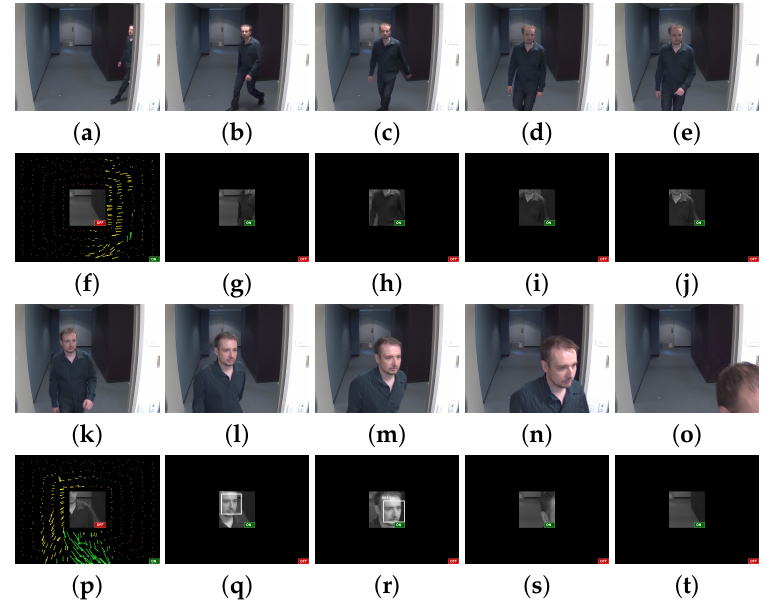
Figure 6. Example of a simulation using one of our ARIMs and a sample sequence from the employed dataset [19]. Images ( a – e ) and ( k – o ) are the original frames; images ( f – j ) and ( p – t ) are the reconstructions with a model that considers an optical flow peripheral representation. Green and yellow arrows indicate motion direction to the right and left sides, respectively, whereas the ON and OFF labels refer to the operational status of the foveal (face detection/recognition) and peripheral (optical flow) regions. Note that the motion analysis, besides triggering foveal analysis, is also able to restart conveniently, as long as faces are not detected in the fovea during a time interval of frames (left-most frame in the fourth